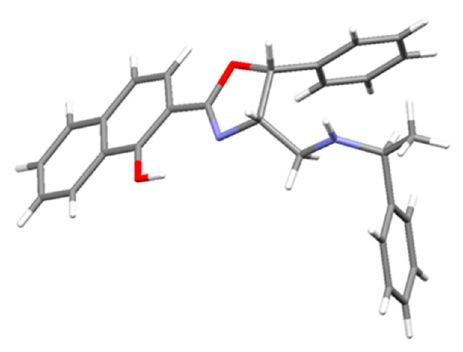
Figure 1. Structure of 4l